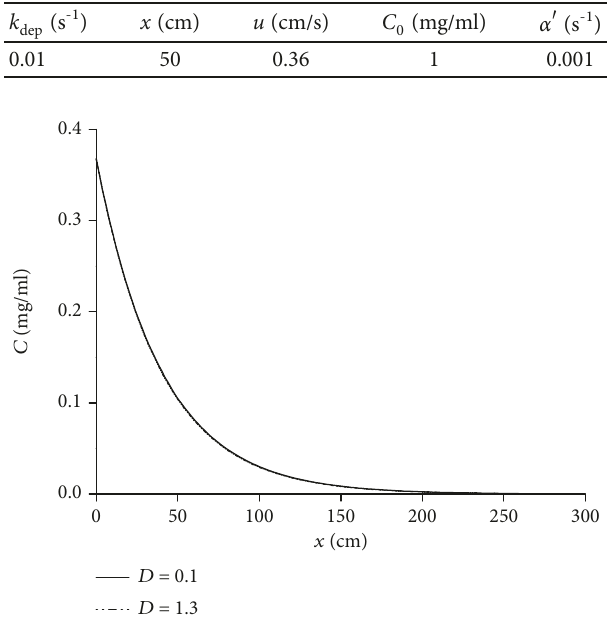
Figure 4: Relationship between particle concentration and distance for two dispersion coe ffi cients, using parameters given in Table 3. Table 3: Model parameters for simulations shown in Figure 4.